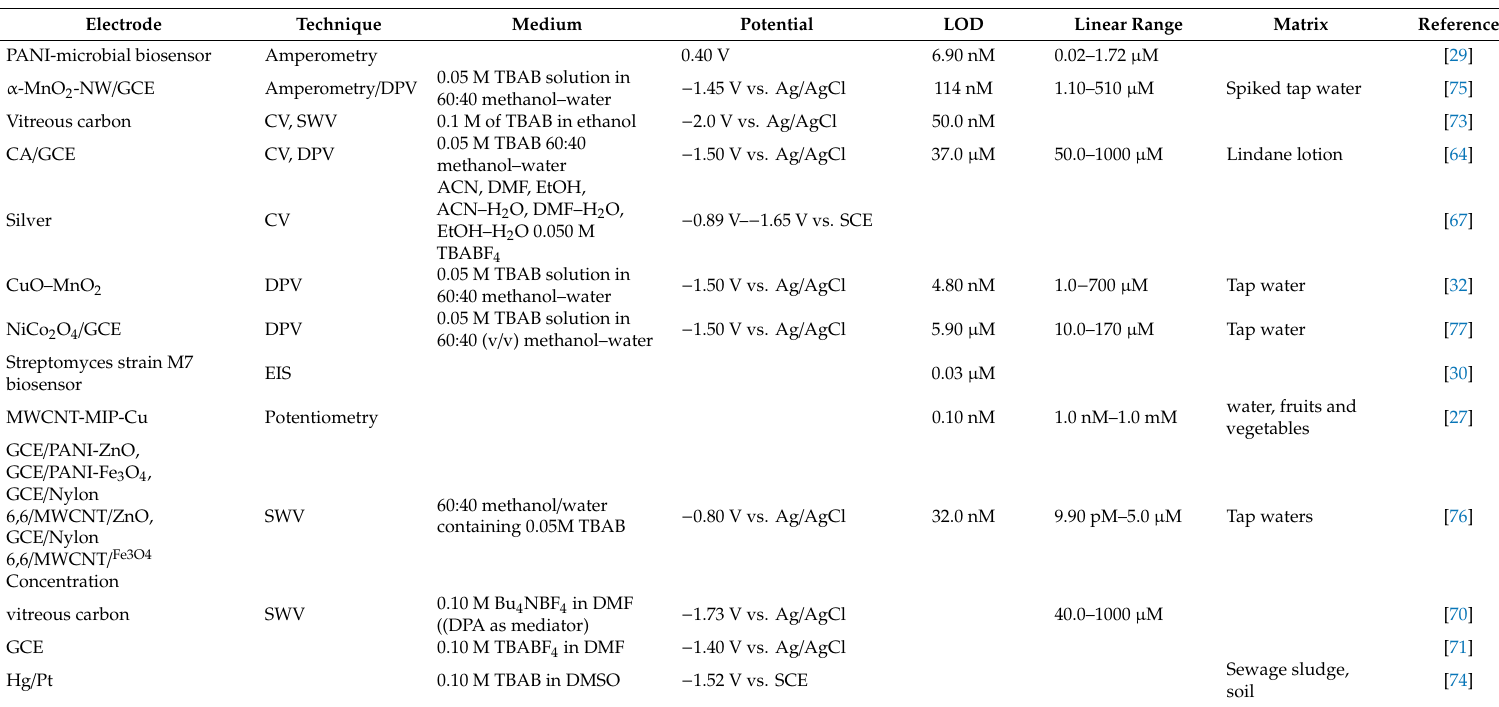
Table 2. An overview of electrochemical techniques, performance characters, medium of measurement and sample matrix for the determination of lindane.